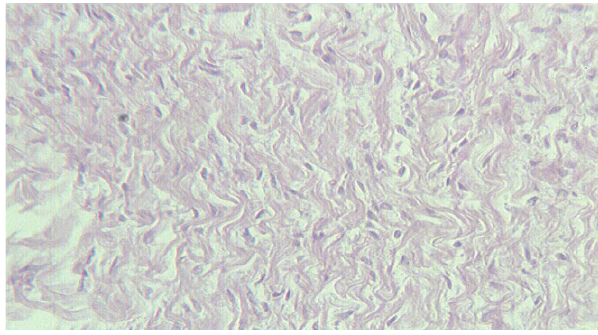
Figure 5 - Oedema, wavy arrangement of